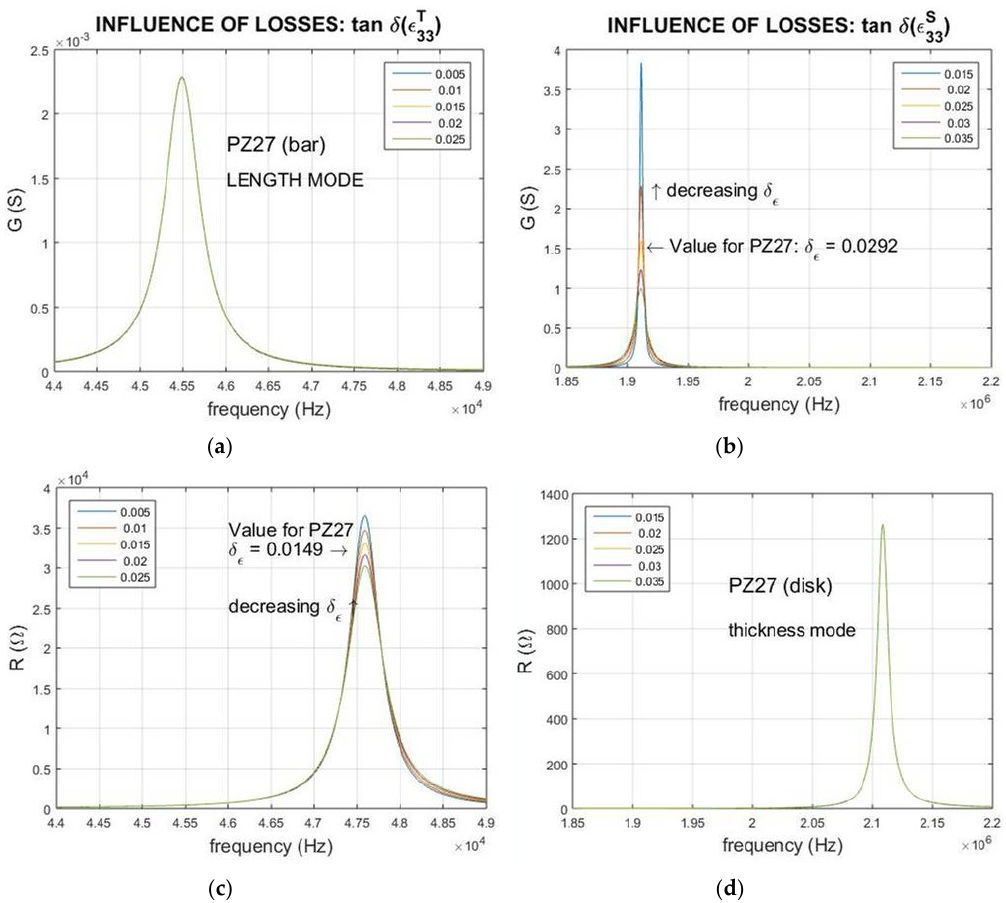
Figure 7. Influence of the dielectric losses on the ( a ) resonance and ( c ) anti ‐ resonance peaks for length extensional mode of a thickness poled bar; dielectric losses modify only (see the R ‐ peak) the elastic anti ‐ resonance peak (also electric anti ‐ resonance). Dielectric losses influence on the ( b ) resonance and ( d ) anti ‐ resonance for thickness extensional mode of a thin disc, thickness poled; dielectric losses modify the elastic anti ‐ resonance, which in this case corresponds to the G ‐ peak (electric resonance) .